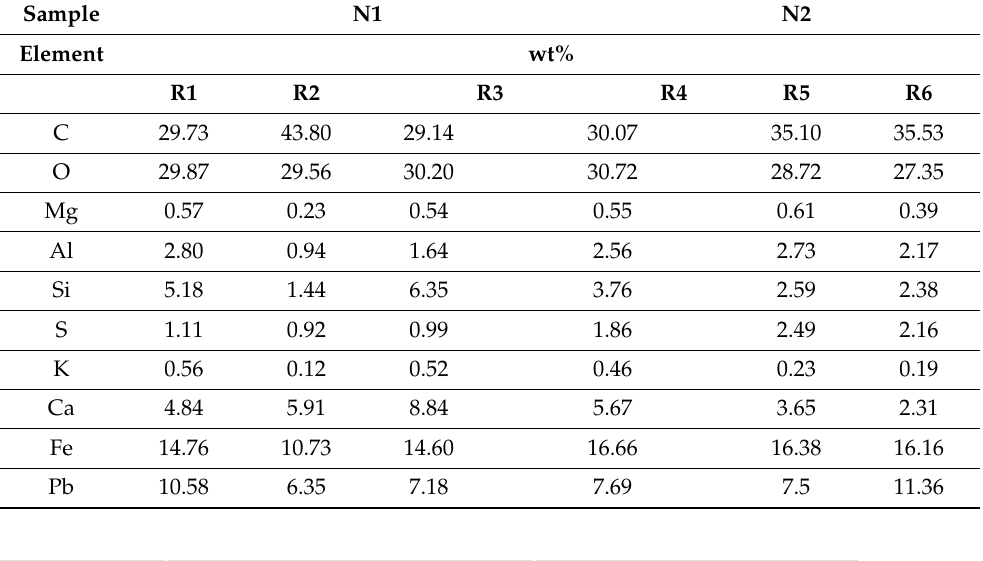
Table 3. Elemental composition (wt%) determined through EDS of the red samples.